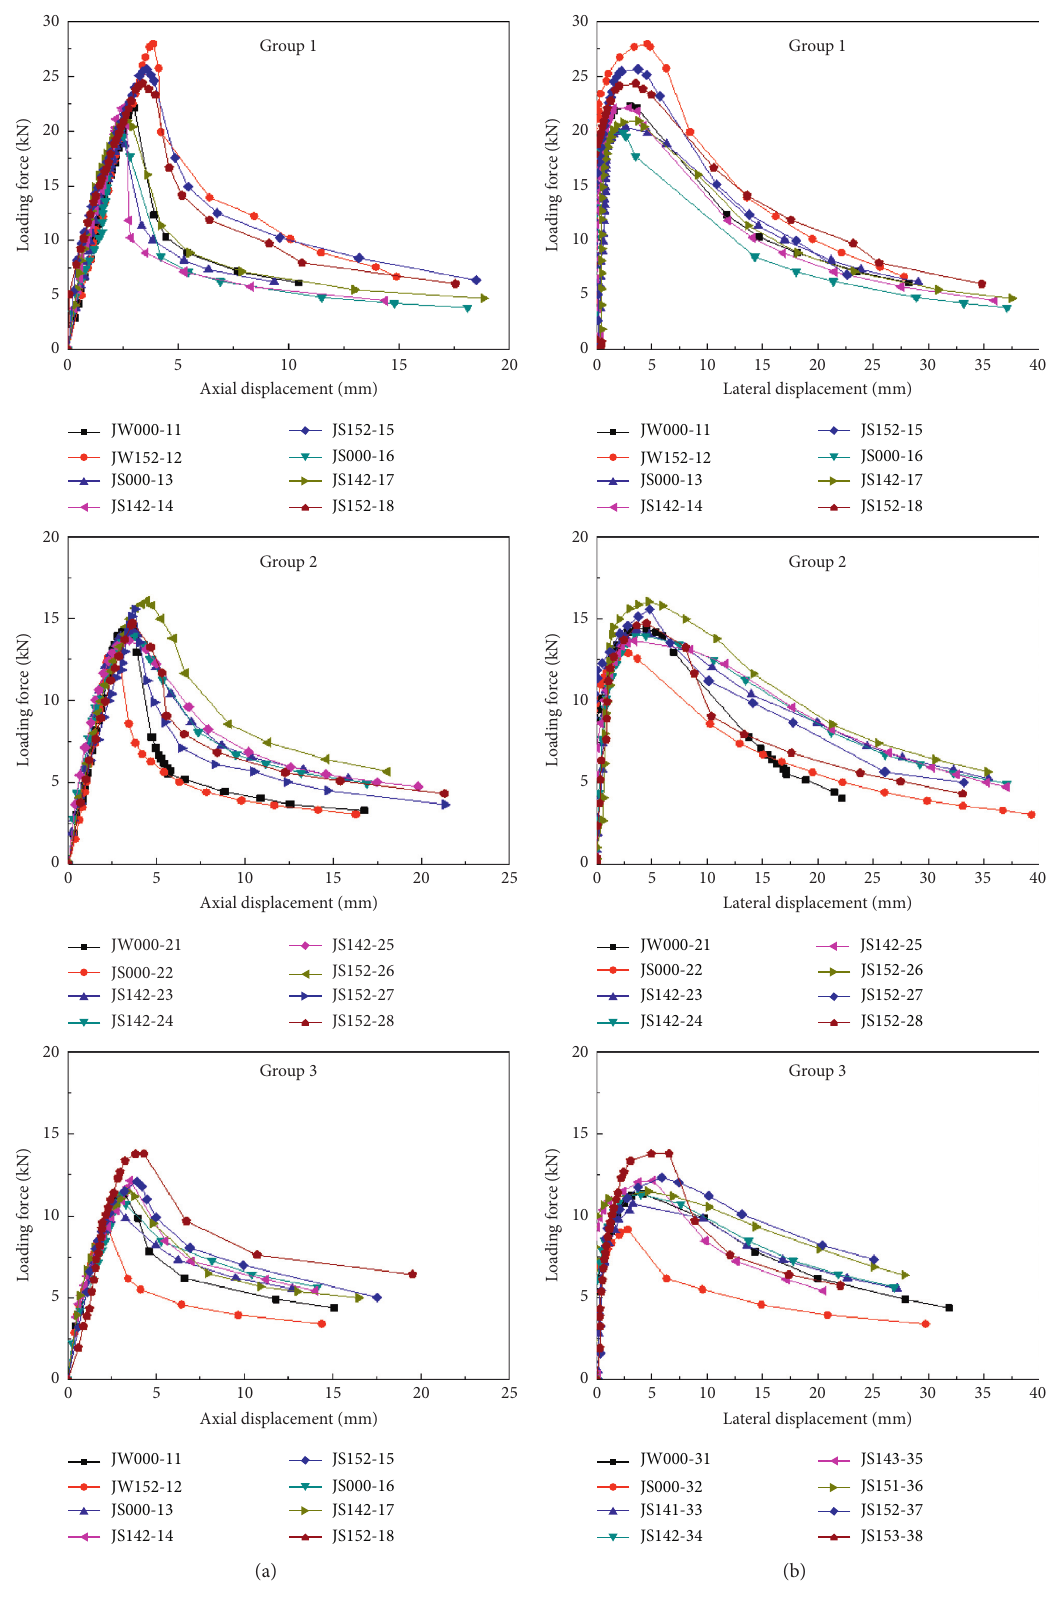
Figure 4: The relation between loading forces and displacements of the specimens. (a) Axial displacement; (b) lateral displacement at the